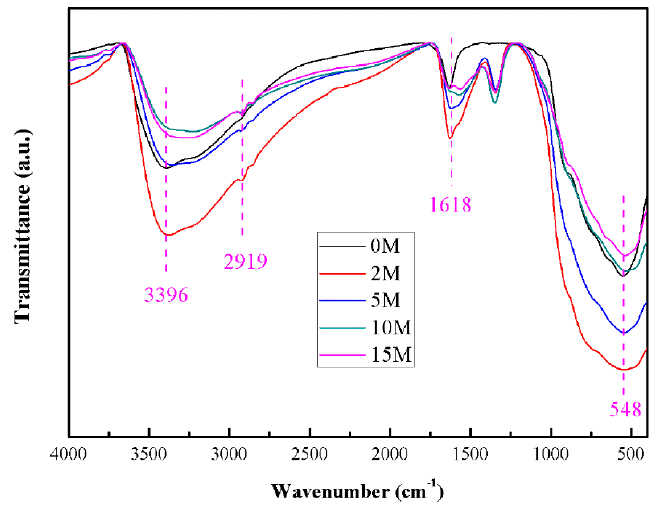
Figure 6. Fourier transform infrared (FT-IR) spectra of as-prepared samples .